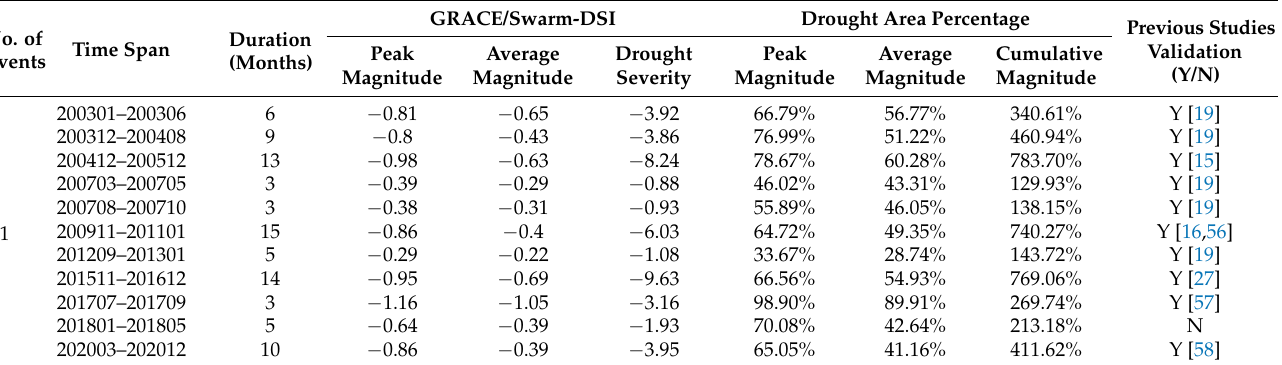
Figure 10. The time ‐ series of GRACE/Swarm ‐ DSI in ARB during 2003–2020. The red and orange bars represent the drought severity and drought area percentage for each month during drought event, respectively. Table 6. Summary table of drought events.